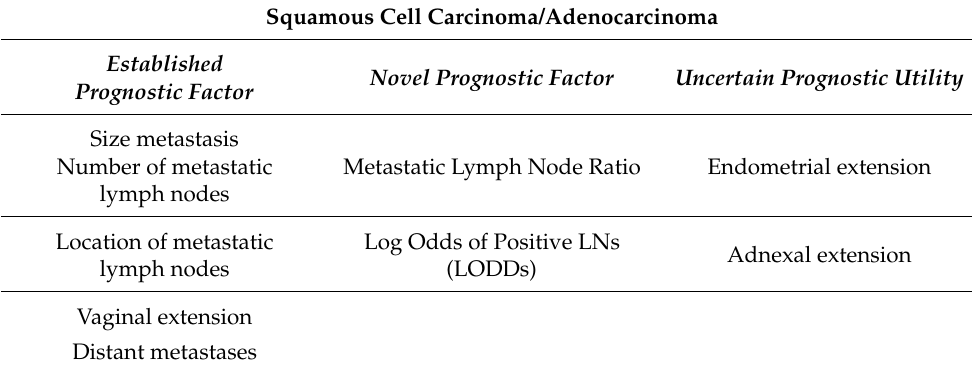
Table 3. Prognostic factors related to advanced-stage